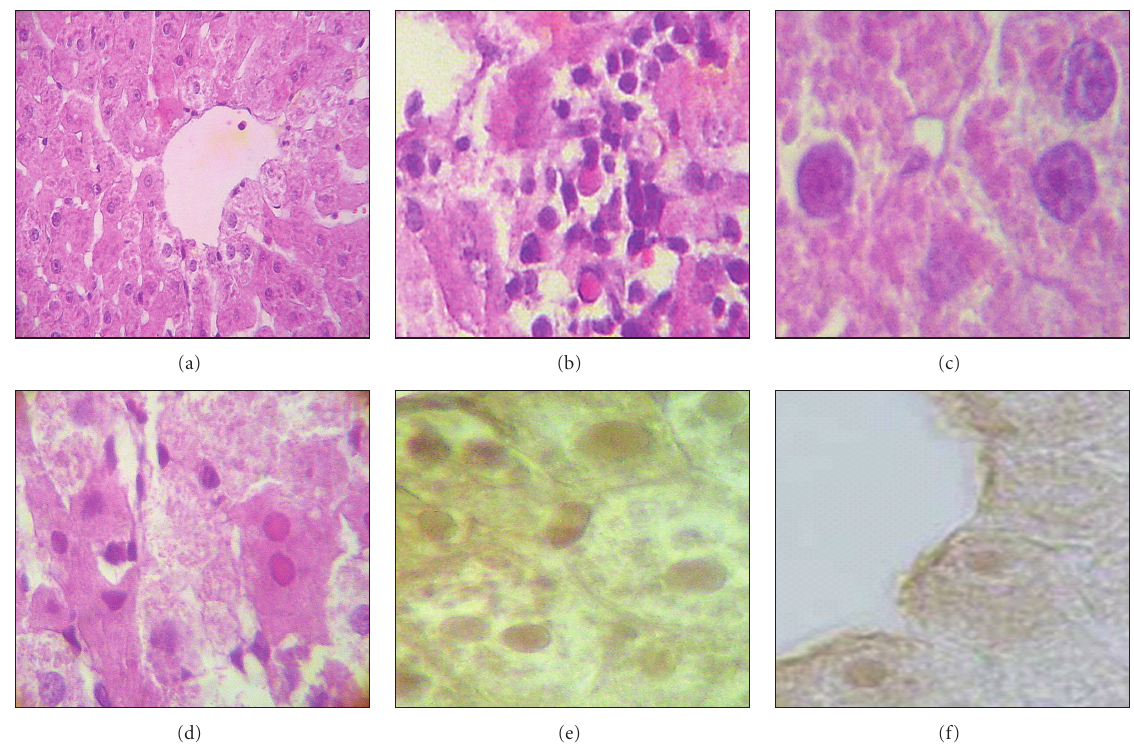
Figure 5: Histological lesions in the liver of rats exposed to lead and treated with glycine 1000 mg/kg for 28 days. (a) Classic liver lobule, sinusoids, portal triads, and portal vein diameter were normal (H&E stain × 20). (b) Inflammatory cell infiltration (H&E stain × 64). (c) Regular membrane cell, heterogeneous cytoplasm (H&E stain × 64). (d) Nucleus hyperchromatic with absence of basophilic staining (H&E